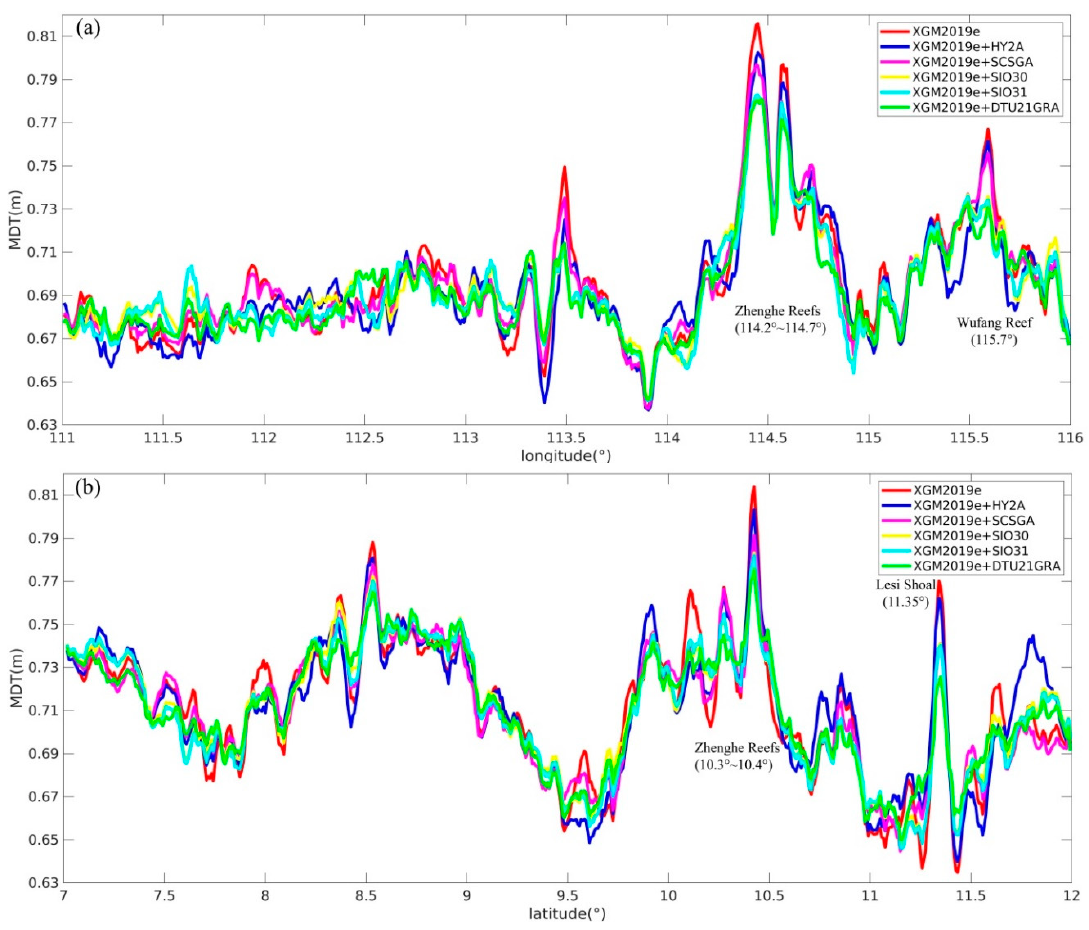
Figure 7. Profiles of various MDTs modeled with different altimetric gravity models along latitude 10.4°N ( a ) and longitude 114.6°E ( b ).